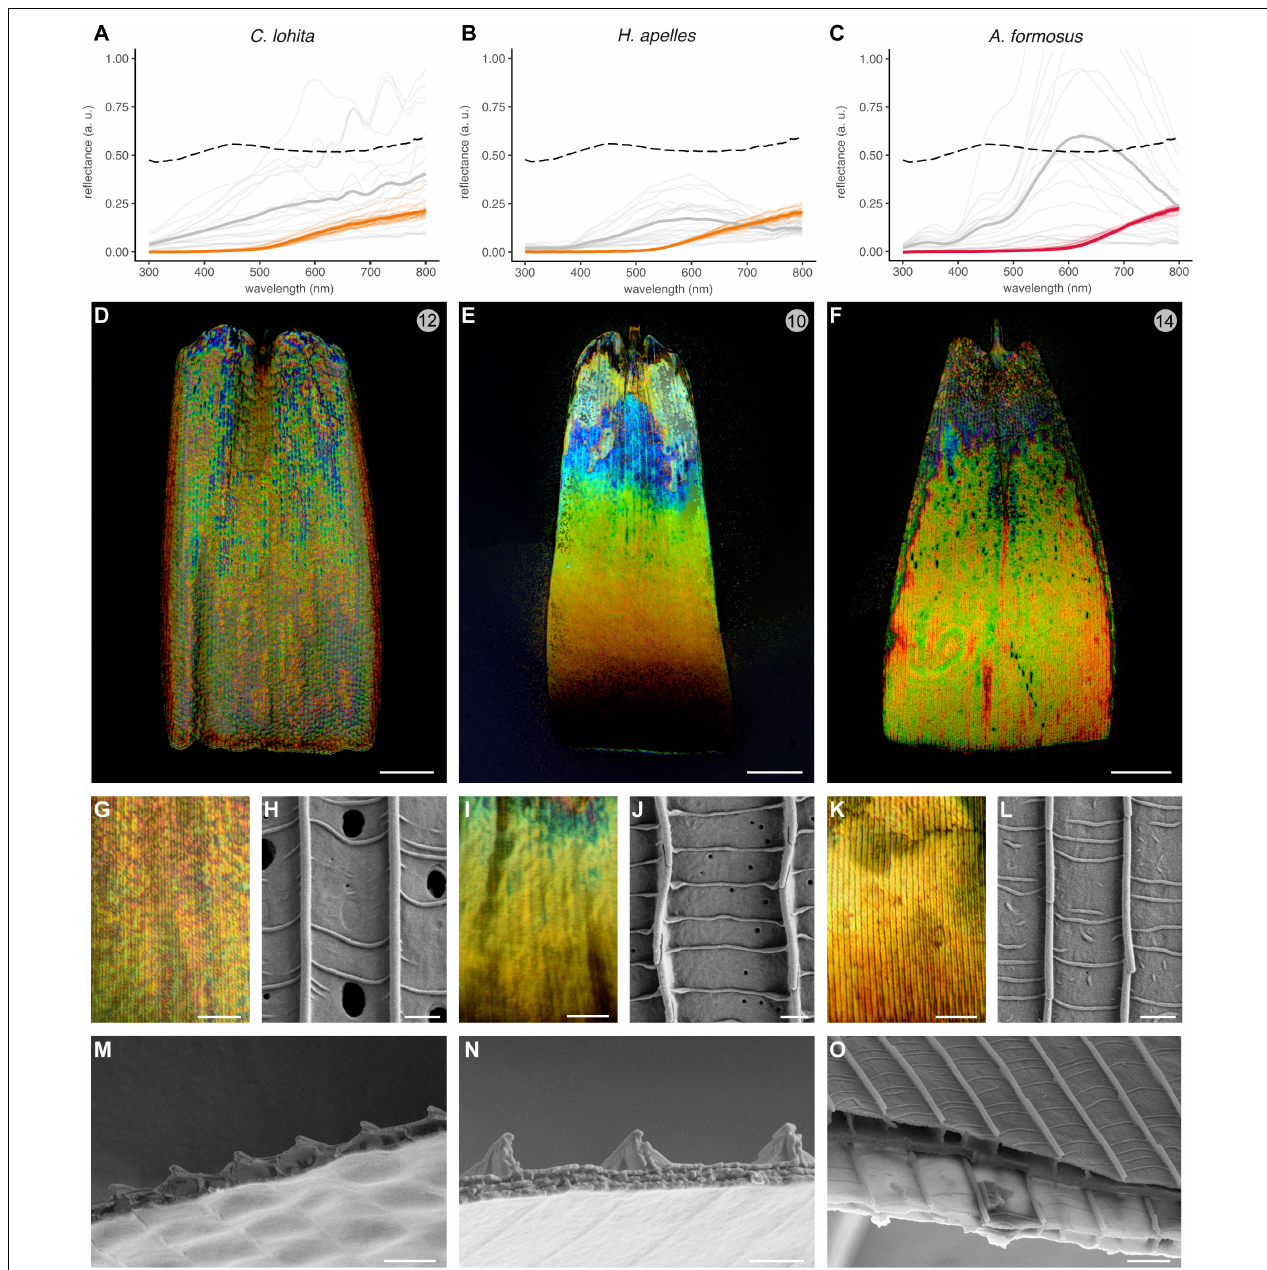
FIGURE 6 | Three distinct optical mechanisms drive broadband reflectance in the Lycaenidae + Riodinidae clade. (A–C) Averaged reflectance spectra of metallic pattern elements (gray lines), compared to an adjacent array of non-specular scales (orange and red lines). Faded lines represent individual measurements within the same wing surface. Dotted lines indicate the averaged spectra of polished aluminum foil for comparison. (D–G,I,K) High-magnification reflected-light microscopy of single metallic scales using a MPlanFLN 50 × lens (D–F) , and an LMPlan Achromatic 100 × lens (G,I,K) . (H,J,L) SEM top views of metallic scales. (M–O) SEM of transversal sections. In A. formosus (O) , more proximal regions of the scale (dark gray, upper) have thicker lower laminae than distal regions (light gray, lower). Scale bars, (D–F) = 20 µ m; (G,I,K) = 10 µ m, (H,J,L,M–O) = 1 µ m.